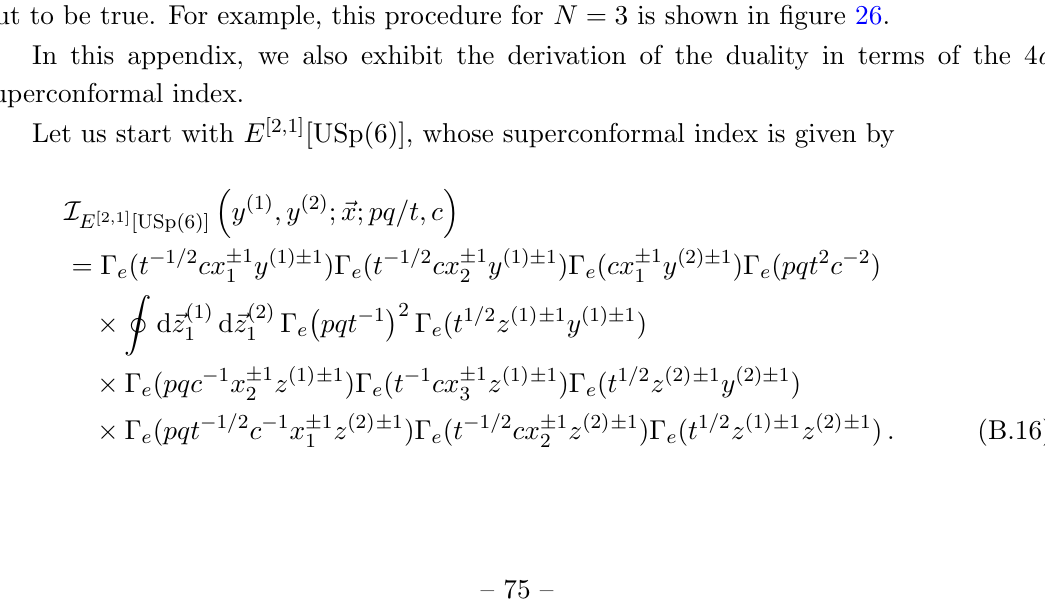
Figure 26 . A direct derivation of the 4 d mirror-like duality between E E [ N (cid:0) 1 ; 1] [USp(2 N )] using the Intriligator-Pouliot